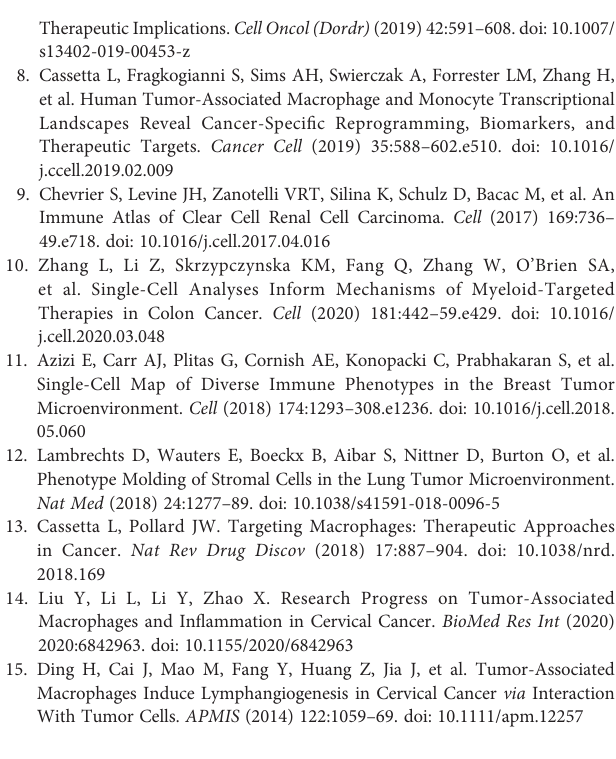
Supplementary Figure 1 | Single-cell transcriptome pro fi ling and TAM gene signatures of the Human BCC TME. (A) UMAP plot showing major immune cell subsets in human BCC TME. (B) UMAP plot of all immune cells colored by enrichment of C1QC + TAM gene signatures. (C) UMAP plot of all immune cells coloredby enrichmentofSPP1 + TAMgenesignatures. (D) UMAP plotofallimmune cells colored by enrichment of M1 gene signatures. (E) UMAP plot of all immune cells colored by enrichment of M2 gene signatures. Supplementary Figure 2 | M1 and M2 gene signatures in TCGA cervical cancer patients. (A) Violin plots showing comparison of M1 gene signatures levels between patientswith FIGO stage1-IB1 andpatients with FIGO stageIB2-IVAin TCGA. Two- sided Wilcoxon test. (B) Violin plots showing comparison of M2 gene signatures levelsbetween patients with FIGO stage 1-IB1 and patients with FIGO stage IB2-IVA in TCGA. Two-sided Wilcoxon test. (C) The Kaplan-Meier overall survival curves of TCGA cervical cancer patients grouped by the gene signature expression of M1 and M2. (D) The Kaplan-Meier Disease speci fi c survival curves of TCGA cervical cancer patients grouped by the gene signature expression of M1 and M2. Supplementary Figure 3 | Heatmaps ofimmune cell in fi ltration in different groups of TCGA cervical cancer patients. (A) Heatmap showing immune cell signatures by XCELL in cervical cancer patients grouped by the gene signature expression of C1QC + TAM and SPP1 + TAM. (B) Heatmap showing immune cell signatures by CIBERSORT in cervical cancer patients grouped by the gene signature expression of C1QC + TAM and SPP1 + TAM. Supplementary Figure 4 | Immunotherapy responses predicted by TIDE in TCGA cervical cancer patients. Immunotherapy responses were predicted by TIDE in cervical cancer patients grouped by the gene signature expression of C1QC + TAM and SPP1 +